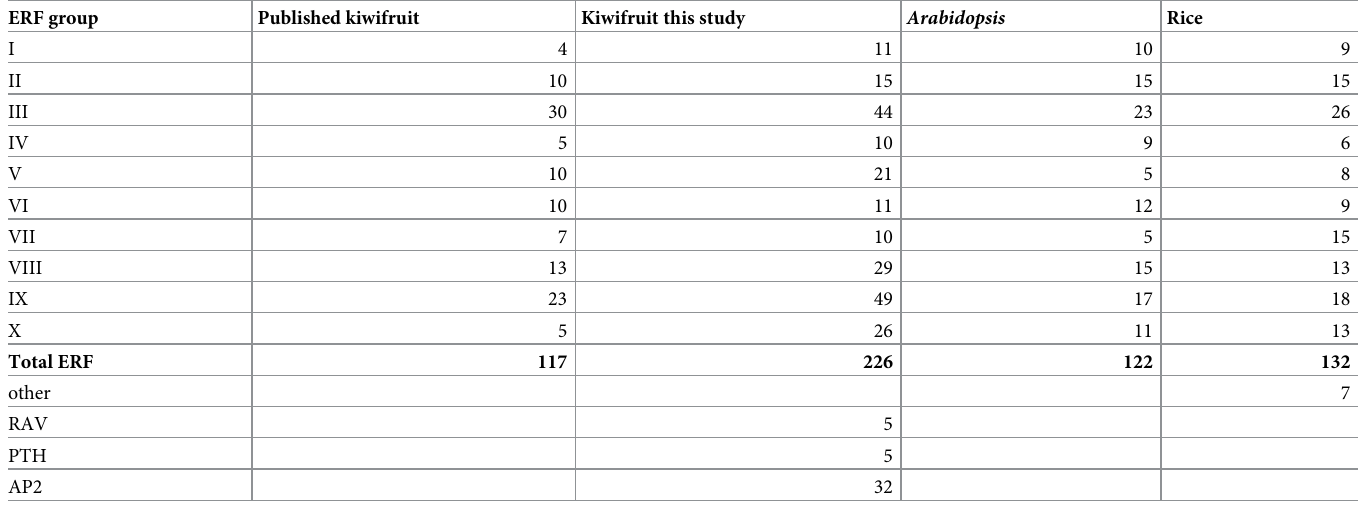
Table 1. Numbers of AP2/ERF genes by cluster group and species. ERF